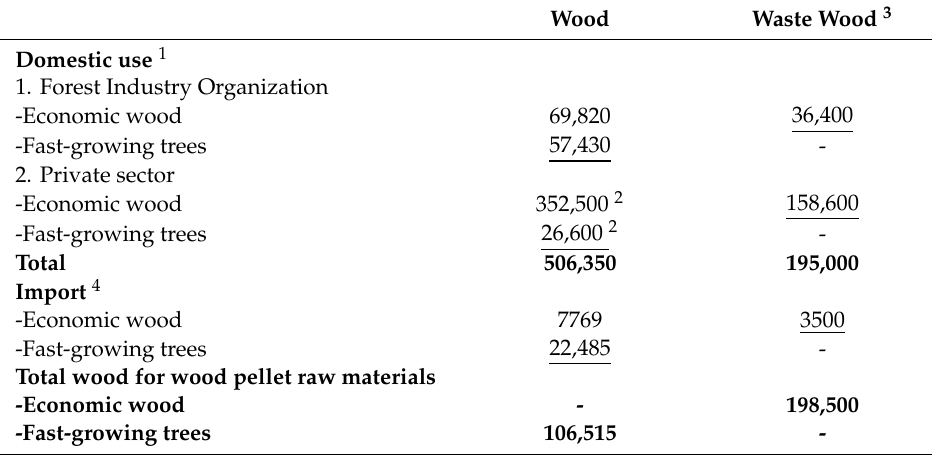
Table 4. Wood consumption in Thailand in 2017, excluding para-rubber wood (tonne).